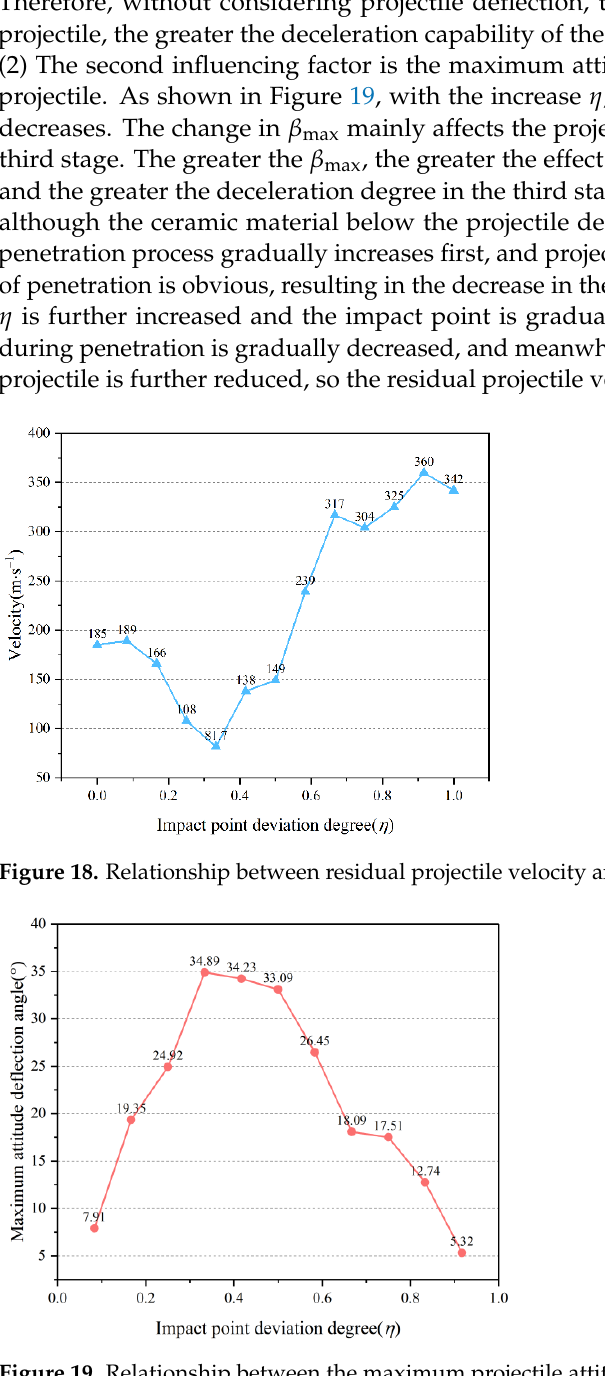
Figure 19. Relationship between the maximum projectile attitude deflection angle β max and impact point deviation degree η .